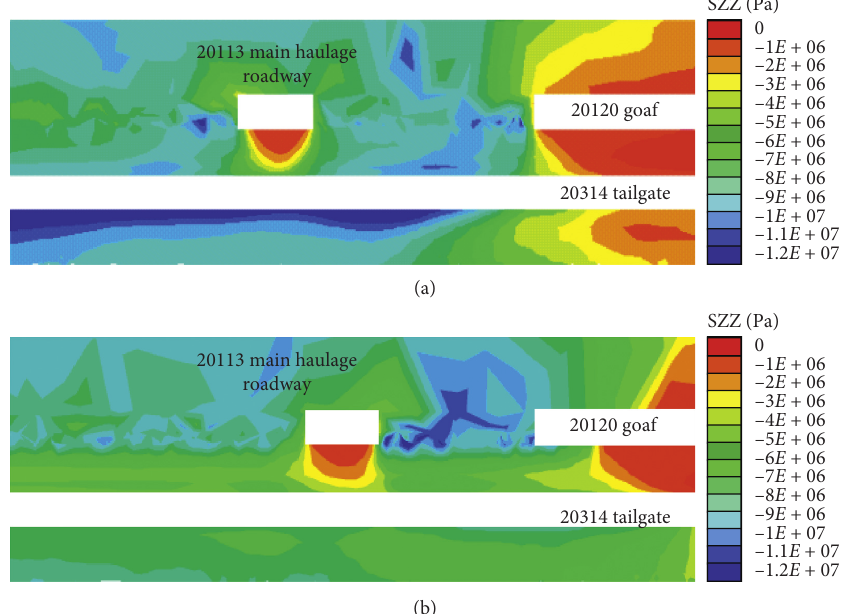
Figure 19: Stress on both sides of the roof of the 2031 auxiliary haulage roadway: (a) coal pillar side; (b) entity coal side.